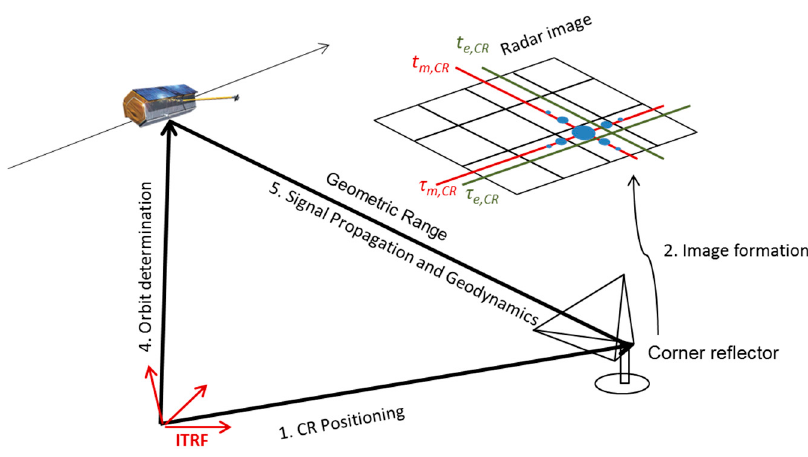
Figure 1. Schematic view of measurement arrangement and procedures.